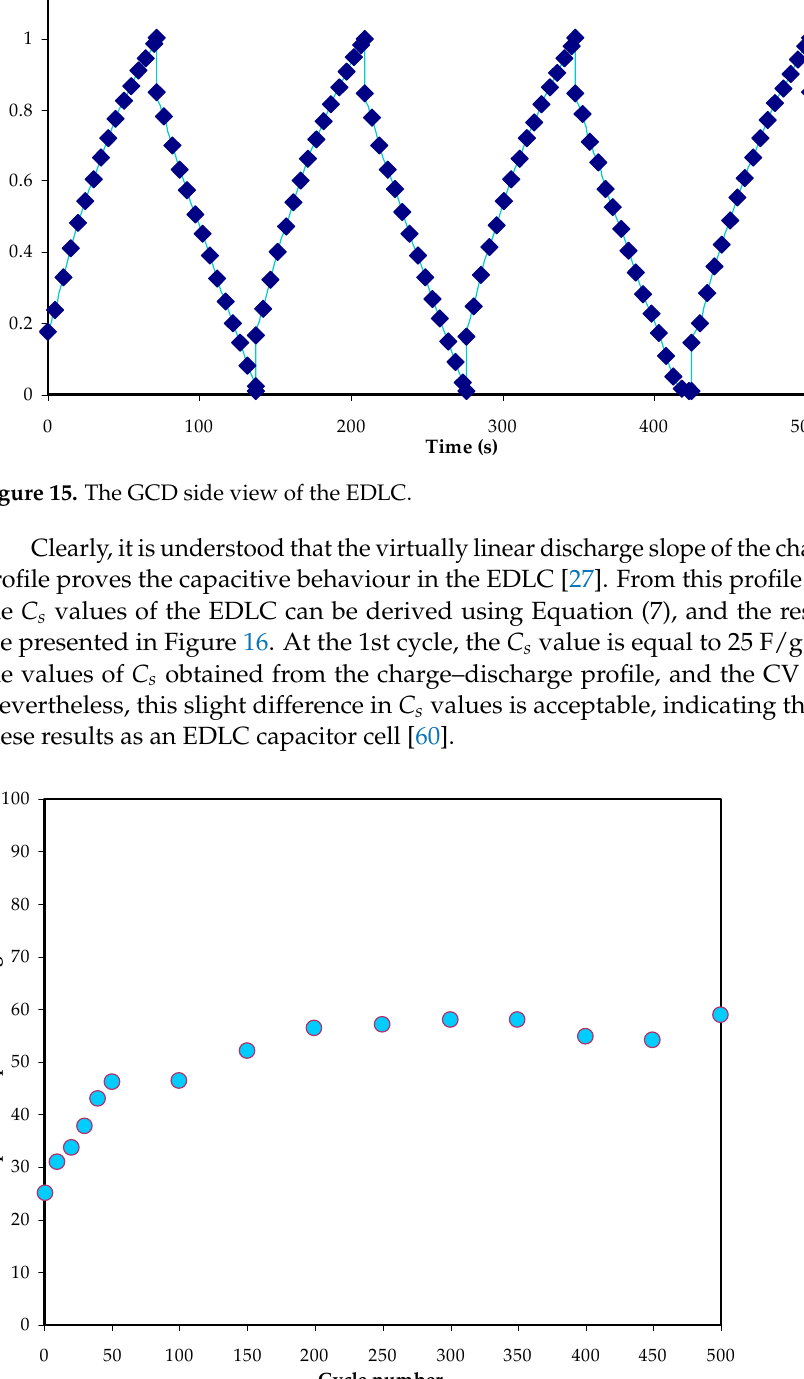
Figure 16. Variation in C s value during 500 cycles.